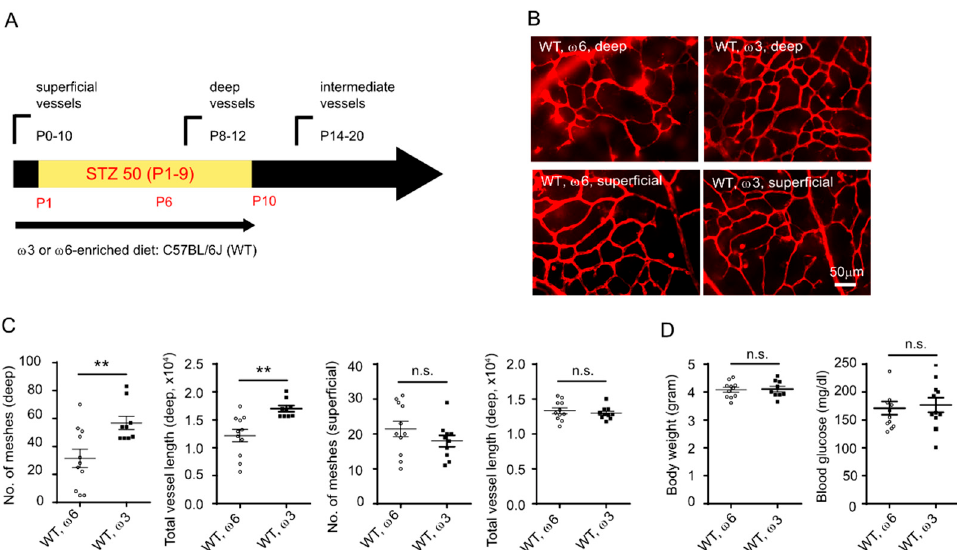
Figure 1. Dietary ω -3 vs. ω -6 LCPUFA supplementation from birth promoted retinal vessel growth in Phase I ROP mice. ( A ) Schematics of hyperglycemic induction in C57BL/6J mice. An amount of 50 mg/kg STZ was i.p. injected daily from P1 to P9. The mice were fed a ω -3 or ω -6 LCPUFA- enriched diet from birth until P10 when the retinas were collected for analysis. ( B ) Representative images of retinal vessels in P10 C57BL/6J STZ-mice fed on ω -3 or ω -6 LCPUFA-enriched diet from birth. Retinal vessels were stained with isolectin. Scale bar, 50 μ m. ( C ) ω -3 versus ω -6 LCPUFA- enriched diet promoted retinal vascular network formation at P10 STZ. n = 9–11 eyes. Unpaired t -test. ** p < 0.01, n.s., no significance. Data was represented as mean ± SEM. ( D ) Comparable body weight and blood glucose in ω -3 versus ω -6 LCPUFA-fed C57BL/6J mice. n = 9–11 mice. Unpaired t -test. n.s., no significance. Data are represented as mean ± SEM.